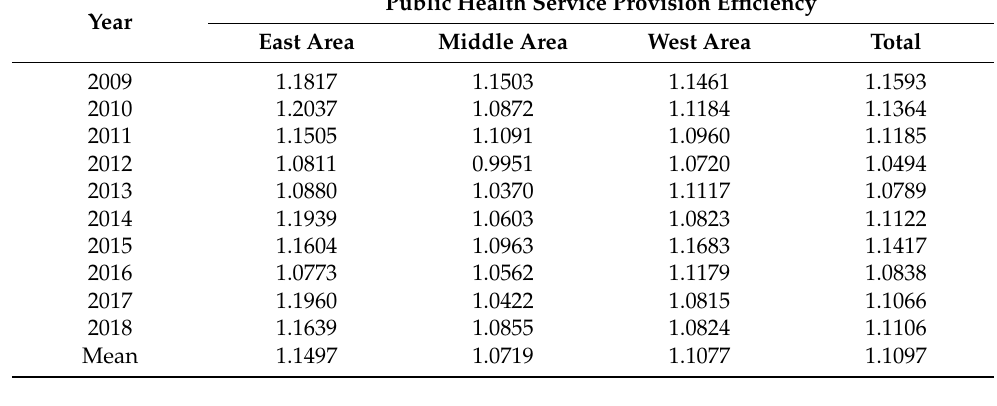
Table 5. Average value of public health service provision efficiency in eastern, central and western regions from 2009 to 2018.